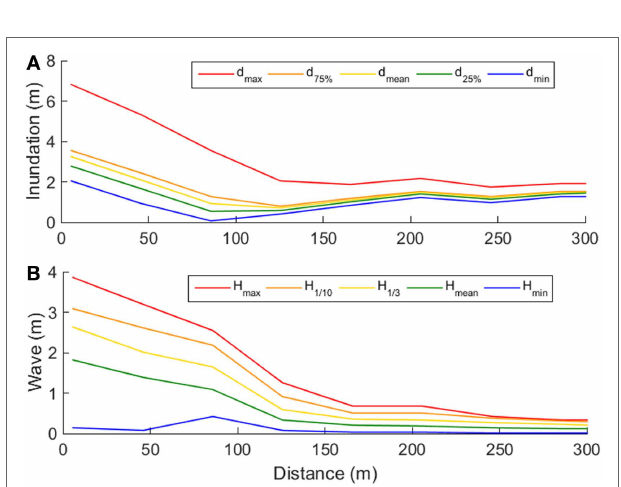
FIGURE 5 | Metrics of (A) simulated flood inundation above ground level and (B) wave action along a transect in Ortley Beach shown in Figure 2B .